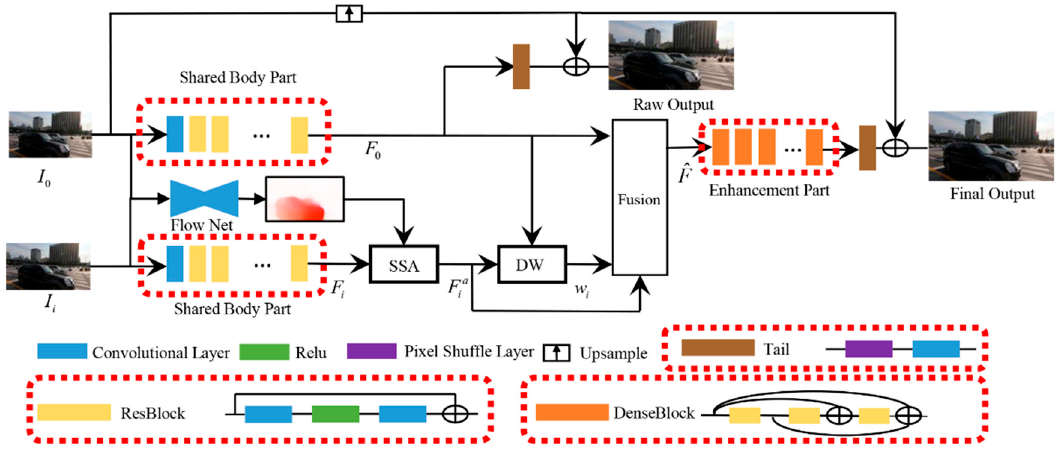
Figure 2. The framework of our method.